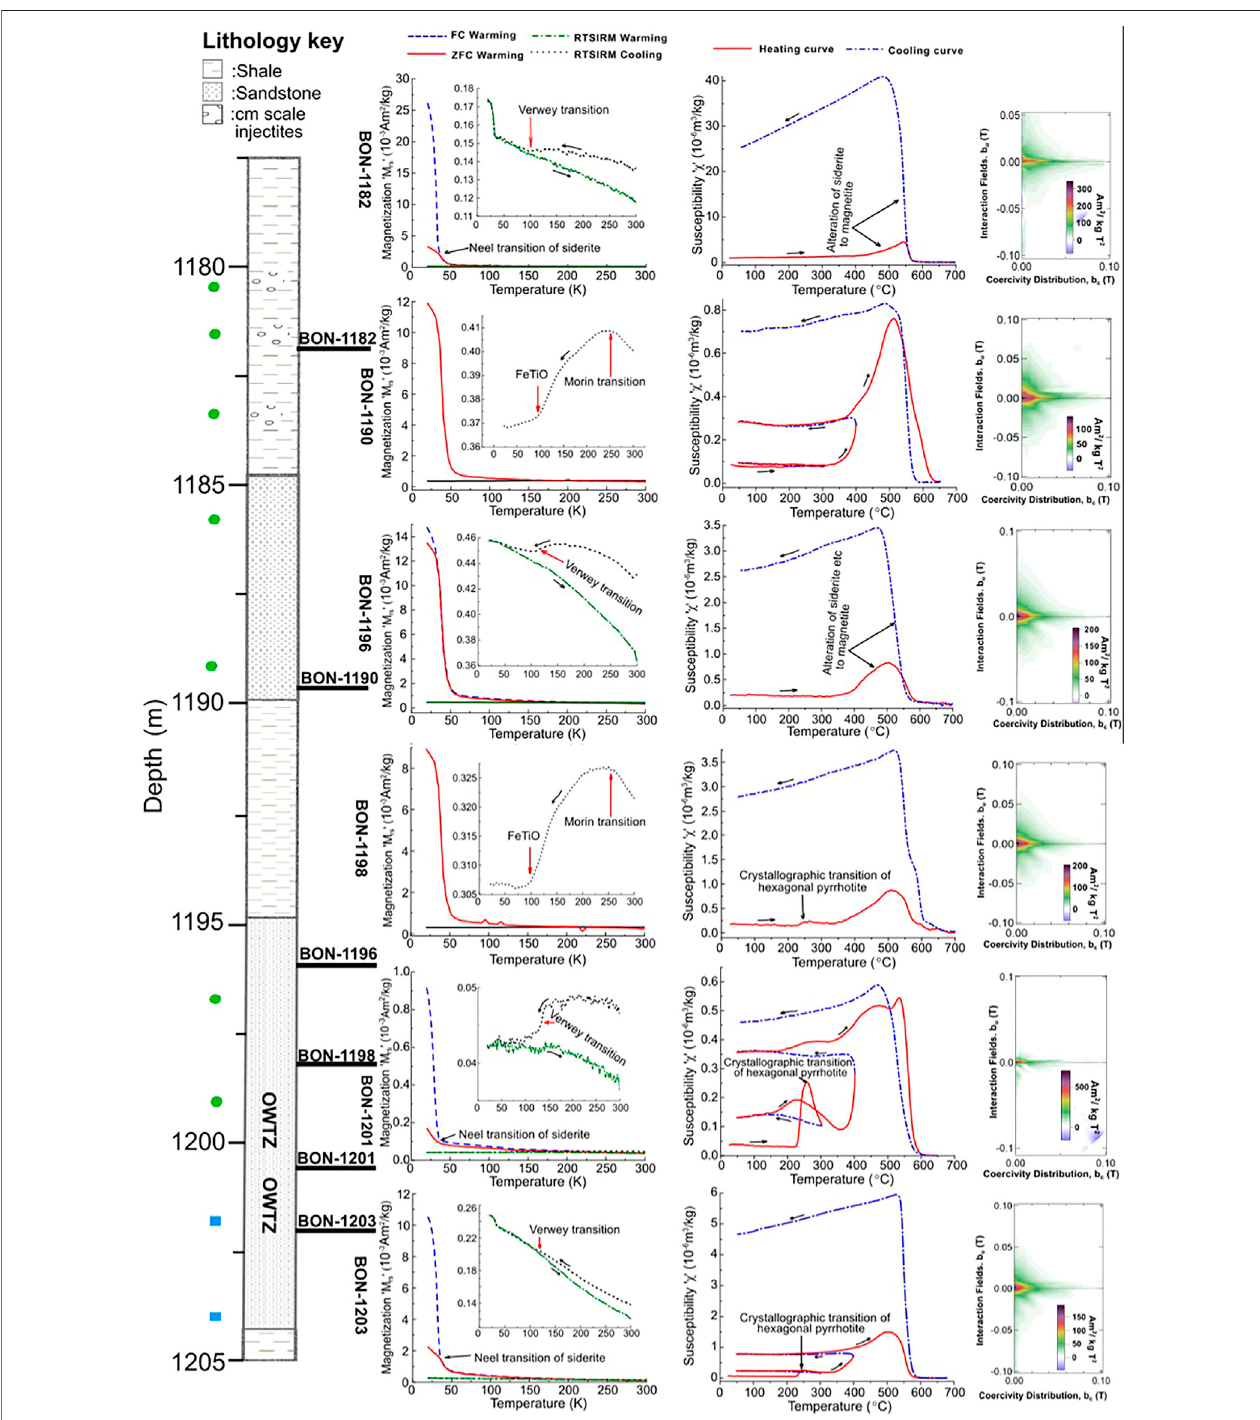
FIGURE8| LTM, HT- χ and FORC measurements for the hydrocarbon reservoir sandstones samples from the Bonneville fi eld. The magnetic minerology of the reservoir sands is dominated by siderite with hexagonal pyrrhotite present around the OWTZ. Ilmenite is also present in sections of the oil leg (BON- 1190, B0N-1196, and BON-1198). Magnetite, titanomagnetite (or their oxidized versions), hematite and potentially other titanohematites are also generally present.